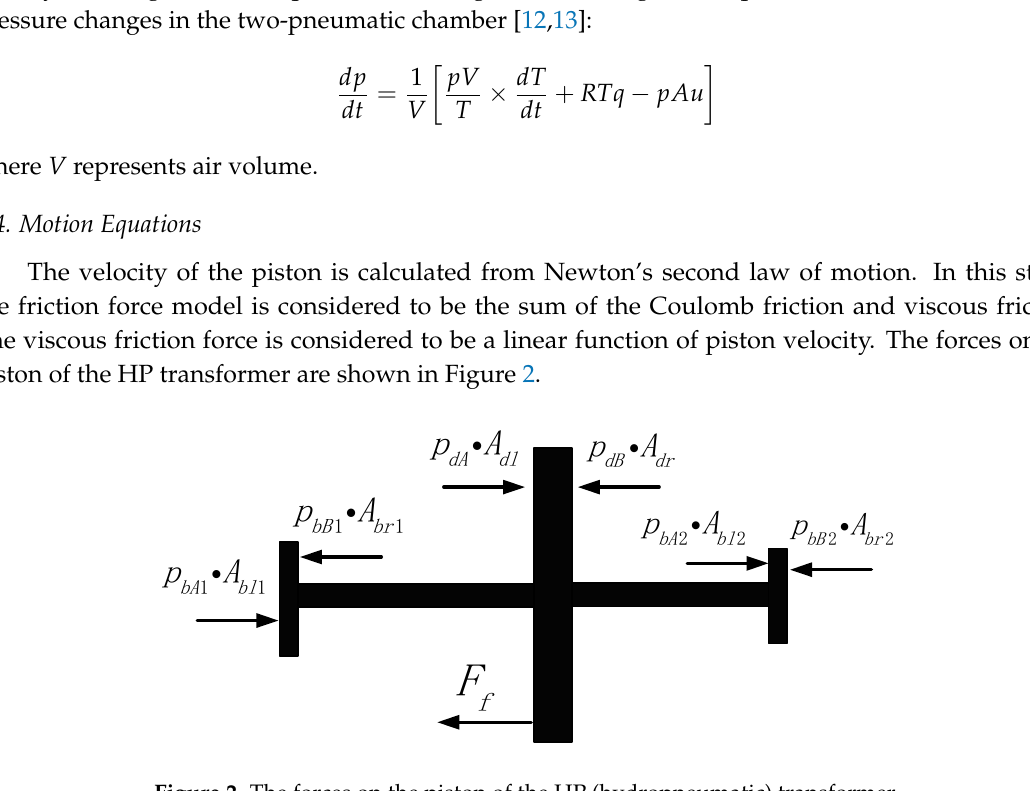
Figure 2. The forces on the piston of the HP (hydropneumatic) transformer.